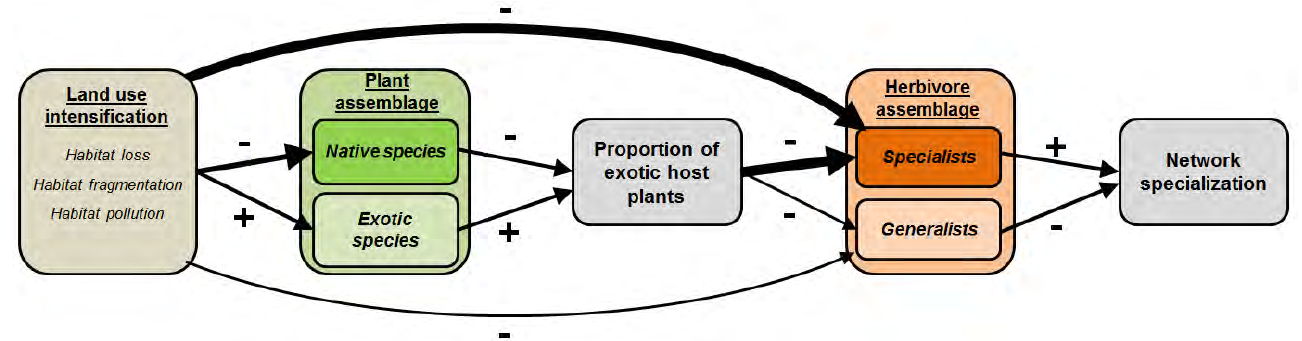
Figure 1. A conceptual model for the effects of land use intensification (LUI) on the specialization of interactions in plant-herbivore networks. First, human land use is expected to have a negative impact on the species richness of native host species, while facilitating the invasion and establishment of exotic plant species. Consequently, plant assemblages under higher levels of LUI are predicted to have a higher proportion of exotic plant species. Both LUI and the increase in the proportion of exotic host plant species would promote the loss of herbivore species at the local scale, but with greater negative impacts on the specialist herbivores than on generalists. Because of the greater reduction in the number of specialist herbivorous species, the proportion of monophagous herbivores is predicted to decrease, whereas the network connectance is predicted to increase with LUI and higher proportions of exotic host plant species. Modified of Araújo et al.